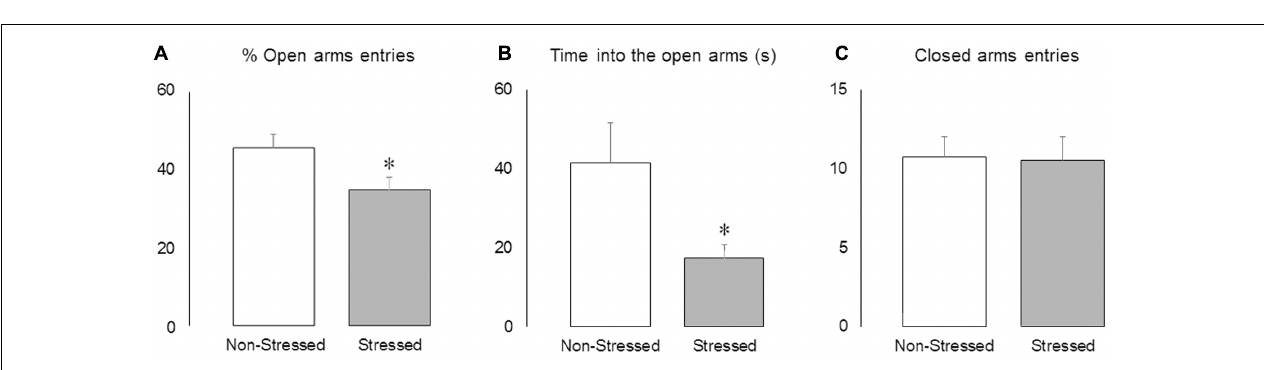
FIGURE 4 | Activity in the elevated plus-maze. (A) Percentage of open arms entries, (B) time spent into the open arms (s) and (C) frequency of closed arms entries in non-stressed controls and socially defeated mice 8 days after the last confrontation. Data are mean ± SEM. ∗ versus non-stressed controls. p < 0.05, n = 12 mice per